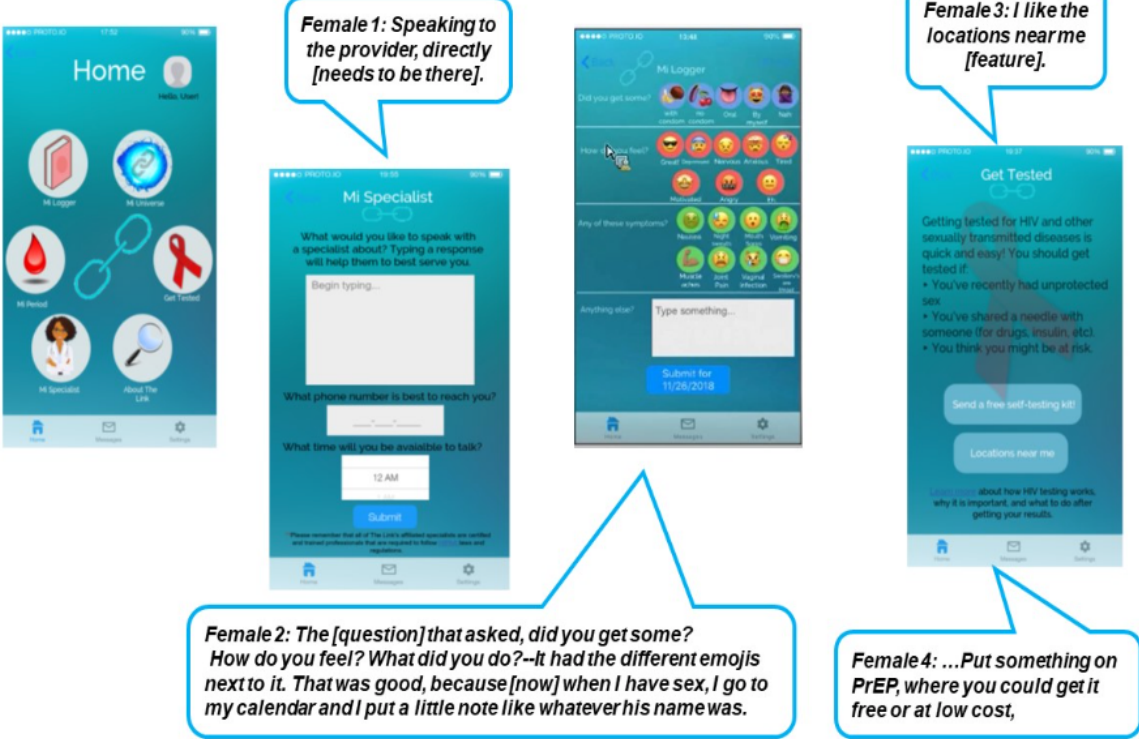
Figure 2. Sample mobile app prototype features and pages. PrEP: pre-exposure